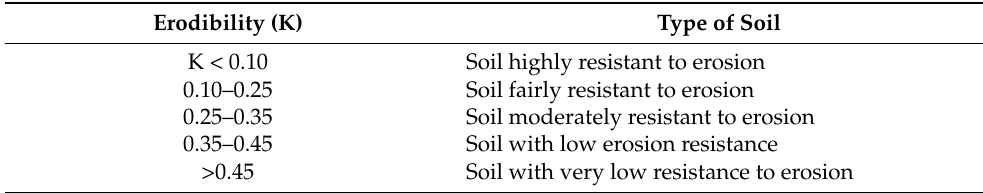
Table 1. Soil susceptibility index classification (Bolline and Rousseau, 1978)